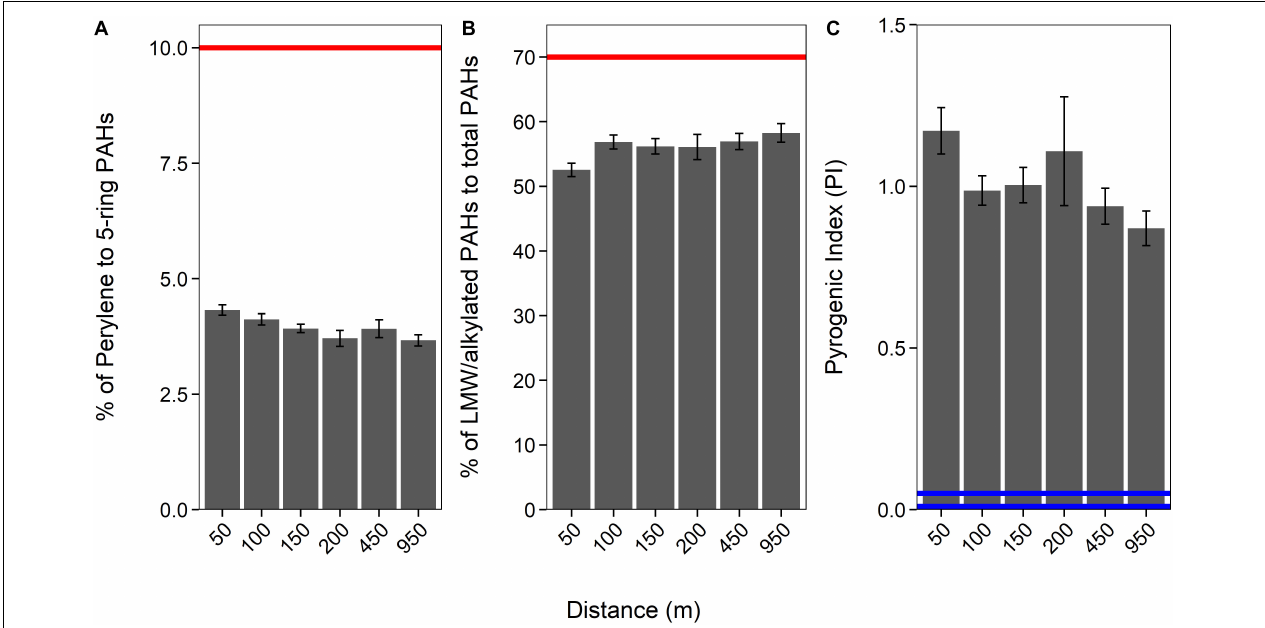
FIGURE 3 | Proportion of perylene to 5-ringed aromatics (A) , of LMW/alkylated PAHs to total PAHs (B) , and the Pyrogenic Index [PI: (cid:54) (3 − to 6-ring EPA priority PAHs) / (cid:54) (5 alkylated PAH series)] over a 950 m cruciform transect (“Distance”; where those sediments sampled further away act as controls), from HMS Royal Oak, Scapa Flow, November 2019. Red lines (A,B) represent the threshold at which PAHs are considered petrogenic. Blue lines (C) represent the points below which PAHs are considered petrogenic (0.01 = lighter refined products and most crude oils and 0.01–0.05 heavy oil and heavy fuel oils).